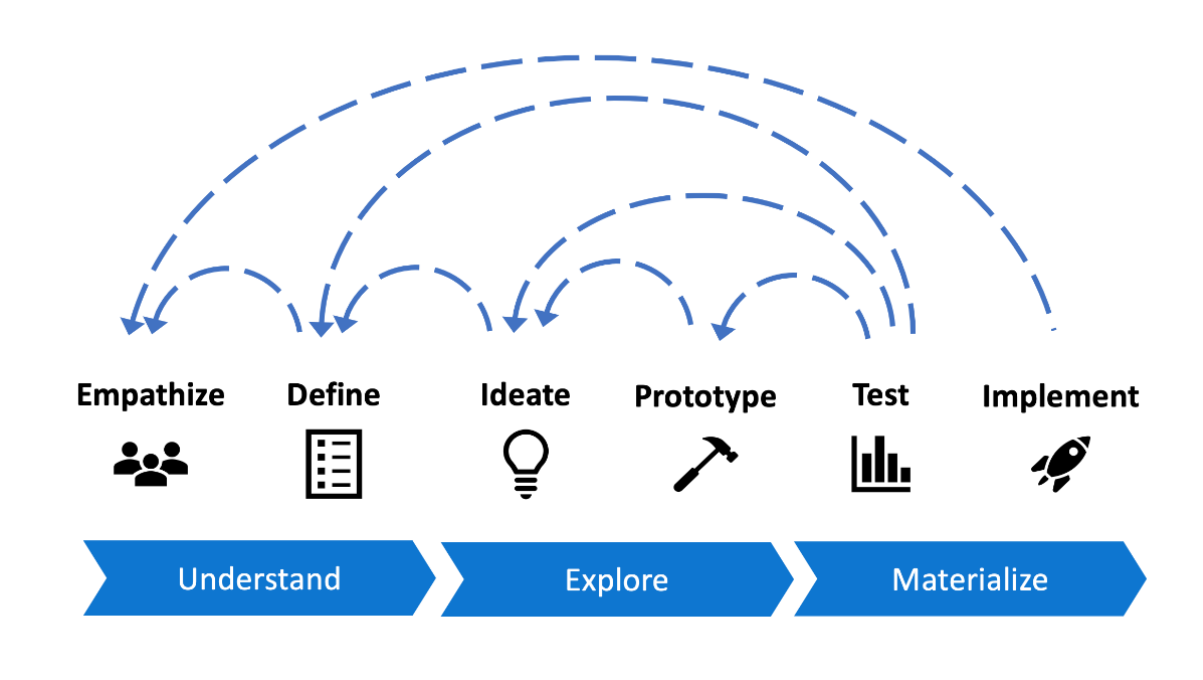
Figure 1. Human-centered design helps designers move from computer code to real-world use. Adapted from Gibbons [7].